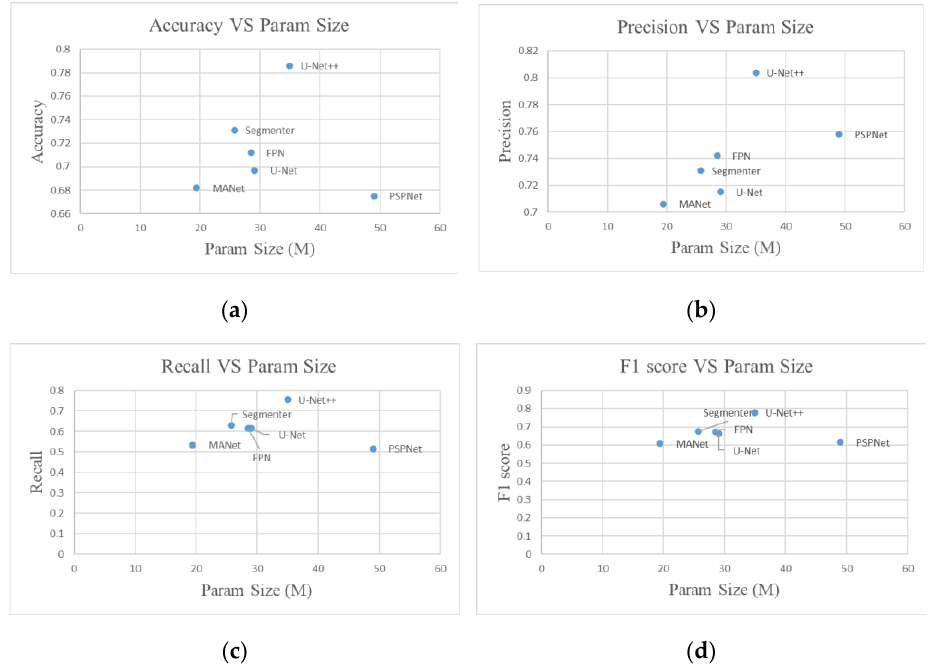
Table 8. Computational complexities of segmentation networks.